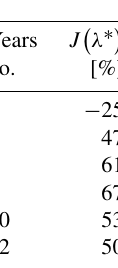
Figure 3. Parameter (a) and state (b) ensembles resulting from the ES application. The forecast and update ensembles are grey and red, respectively, while the observation data are the green stars. Table 2. Testing ES approach in a predictive sense. Variations J of AES index for the parameter λ ∗ and the state u z for the assimilation of increasing amount of GPS recordings.